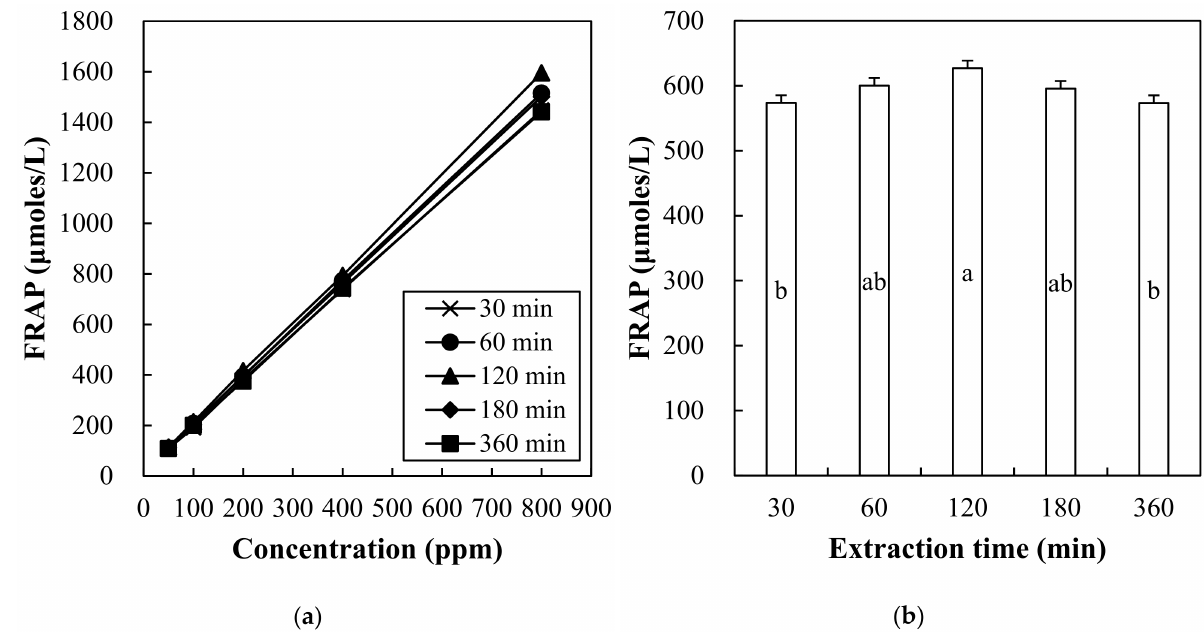
Figure 3. Change in ferric reducing antioxidant power (FRAP) of red maple leaf extracts at different concentration ( a ) and the impact of extraction time on the FRAP value ( b ). Error bars represent standard error of the means. a,b Means with the same letter are not significantly different ( p ≥